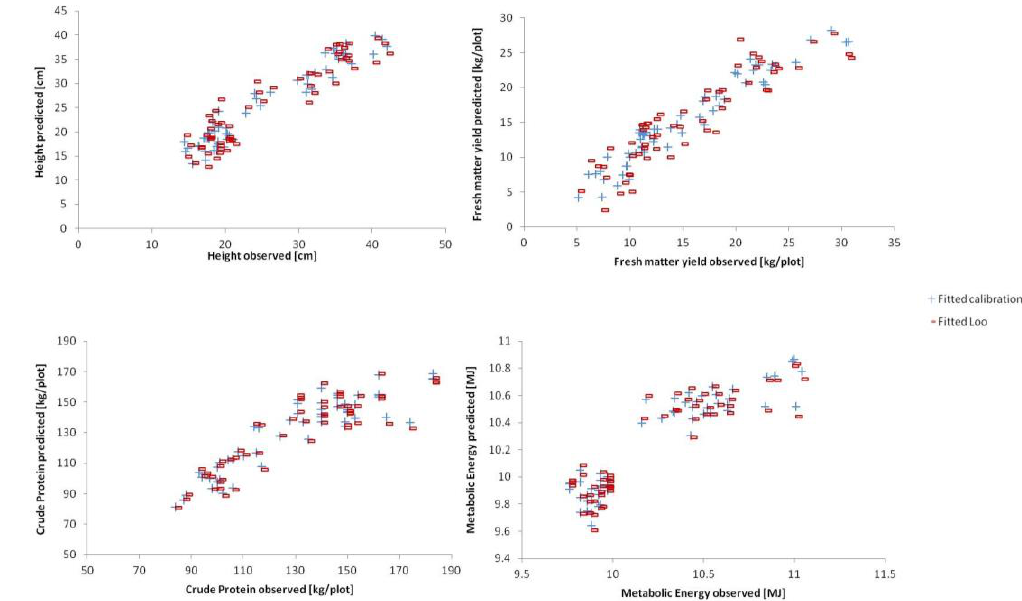
Figure 11. Scatterplot of the measured vs. predicted values for the best PLSR models presented for the integrated dataset of May and October and composed by both organic and inorganic fertilization plots (LOO = Leave-One-Out validation).